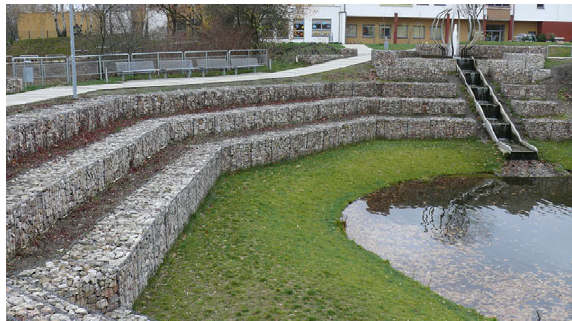
Fig. 11. Gabions – decorative reinforcement (built of rock fragments) of the slopes of the so-called “pits”, i.e. former „Count’s clay pit ponds”. Photo by M. Górska-Zabielska